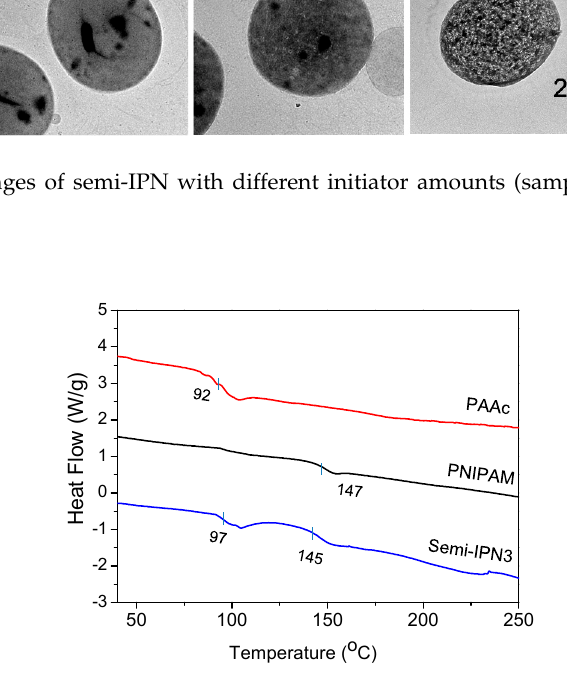
Figure 8. DSC curves of the PAAc, PNIPAM, and semi-IPN3 microspheres.